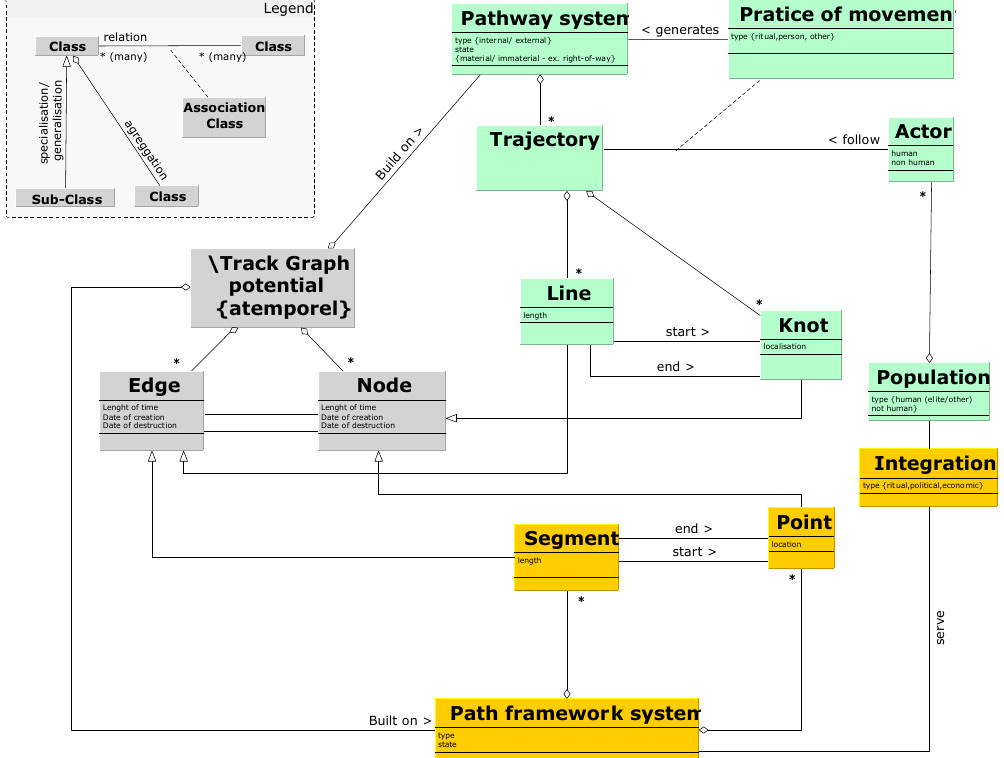
Figure 12. Theoretical structure of the track graph, pathway system, and path framework system.